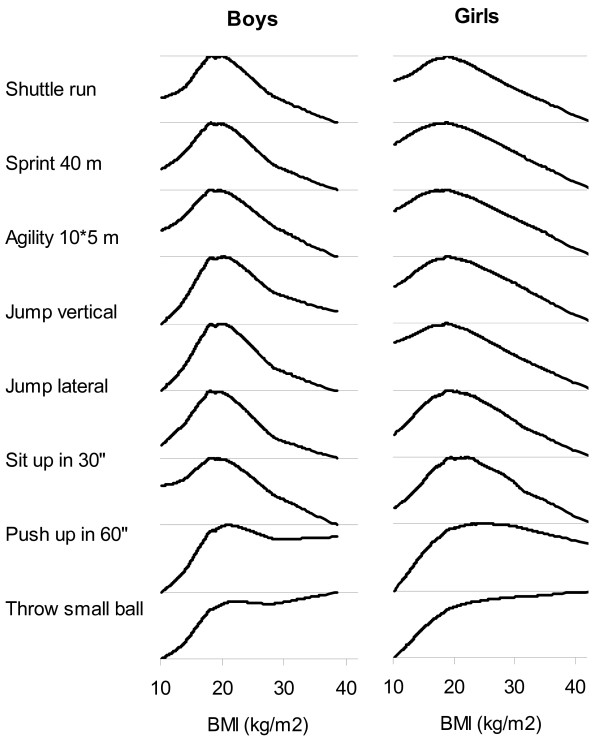
Locally weighted regression between fitness scores and body mass index for 9 fitness tests in 2202 boys and 2141 girls aged 12–15 years. Body mass index and fitness scores are standardized for age and fitness scores are calibrated to range from 0 (lowest performance) to 1 (highest performance).